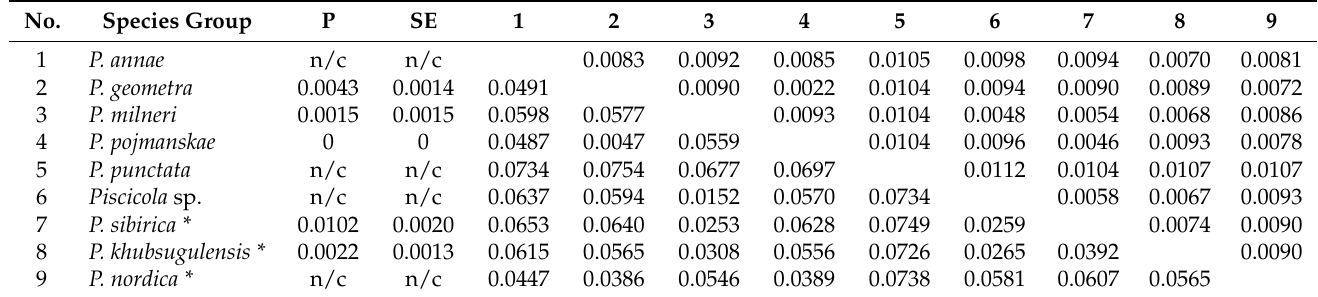
Table 3. Estimates of average evolutionary divergence over sequence pairs within and between the Piscicola species